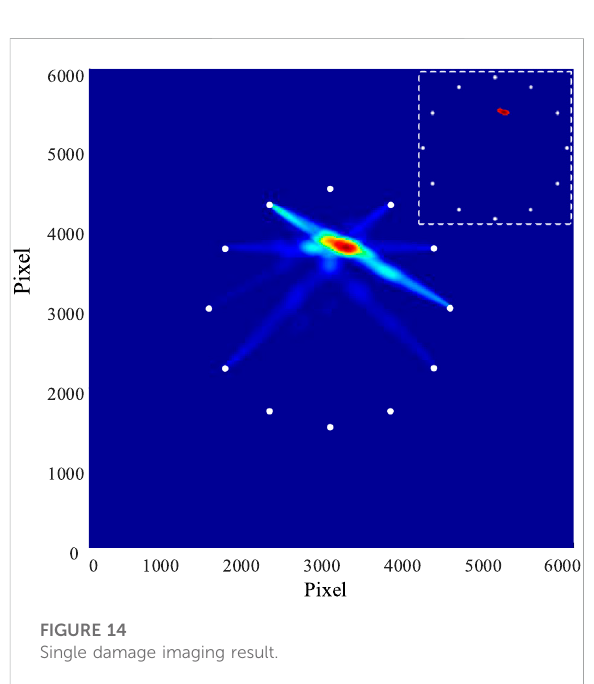
FIGURE 14 Single damage imaging